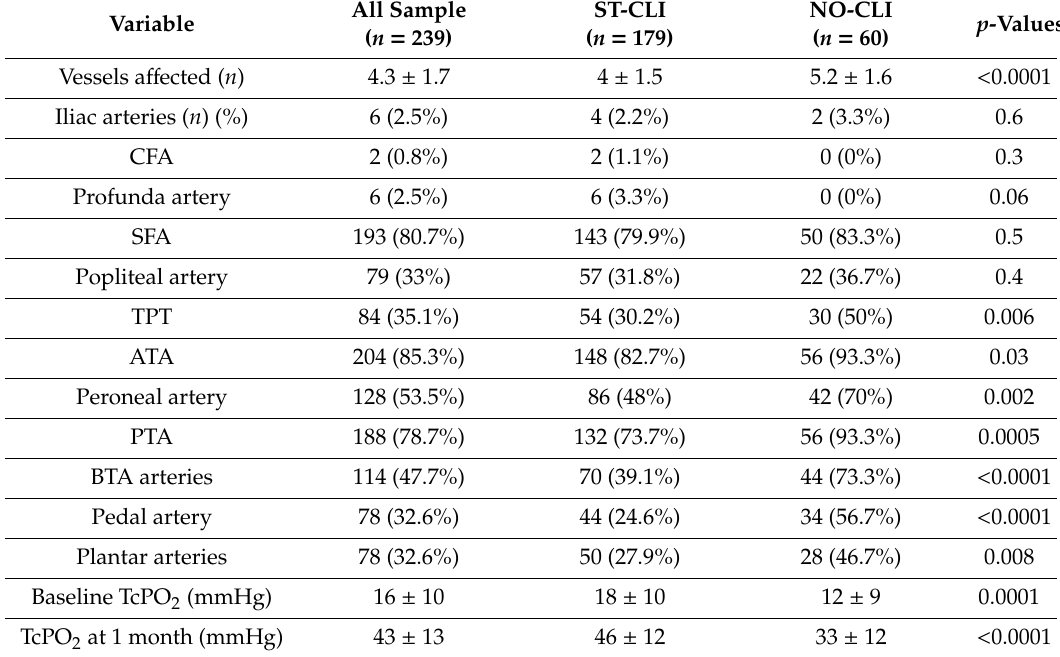
Table 2. Distribution of arterial lesions and vascular findings. CFA: common femoral artery; SFA: superficial femoral artery; TPT: tibio-peroneal trunk; ATA: anterior tibial artery; PTA: posterior tibial artery; BTA: below-the-ankle. TcPO 2 : transcutaneous oximetry. A p -value < 0.5 was considered statistically